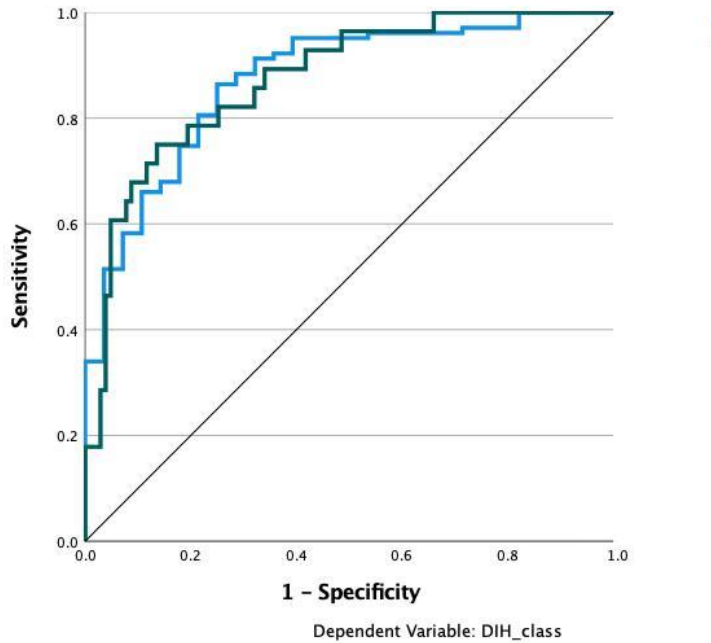
Figure 3. Prediction of hospital stay with multilayer perceptron (MLP). Input layer: feature variables (22 units). Hidden Layer: 2 units, activation function: hyperbolic tangent. Output layer: dependent variable Hospital stay (2 units), activation function: softmax, error function cross-entropy. The number of units in the hidden layer was determined by the testing data criterion: the best number of hidden units is the one that yields the smallest error in the testing dataset. Train/Test/Validation split: 80/10/10. Percent incorrect predictions on training set: 14.5%; percent incorrect predictions on testing set: 14.3%; percent incorrect predictions on holdout set: 10.0%; 0 refers to the prediction of the normal class; 1 refers to the prediction of the prolonged LOS class. AUC: 0.873.